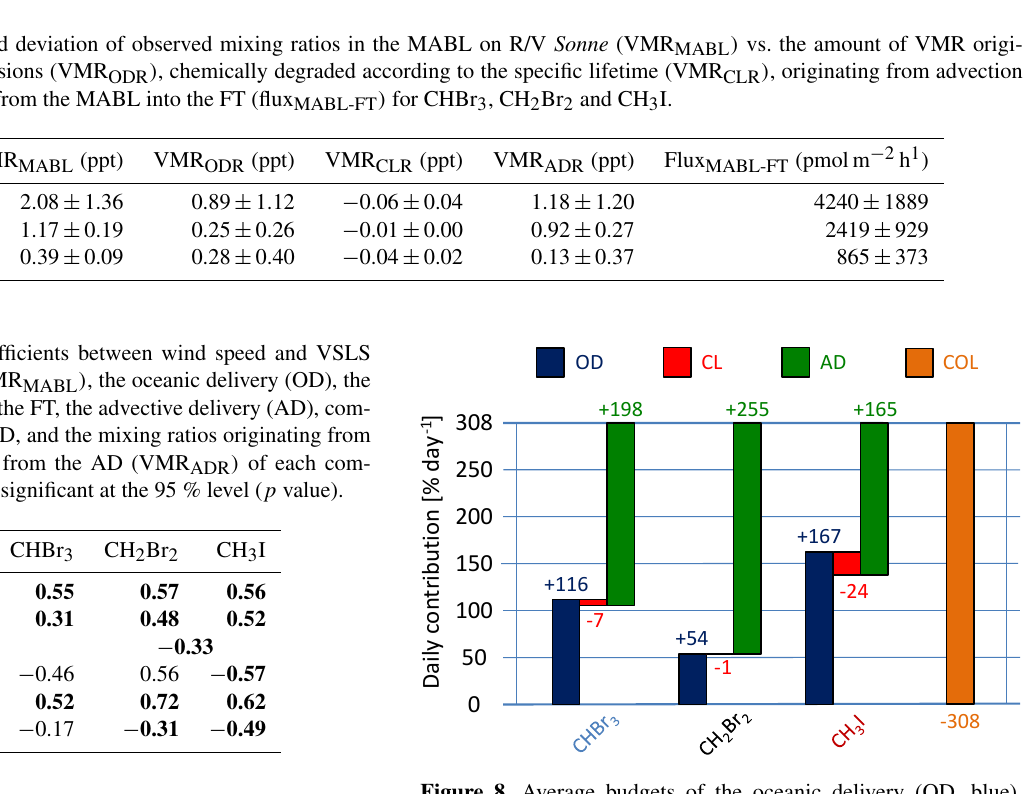
Figure 8. Average budgets of the oceanic delivery (OD, blue), chemical loss (CL, red), advective delivery (AD, green) and con- vective loss (COL, orange) of CHBr 3 , CH 2 Br 2 and CH 3 I in the marine atmospheric boundary layer (MABL).